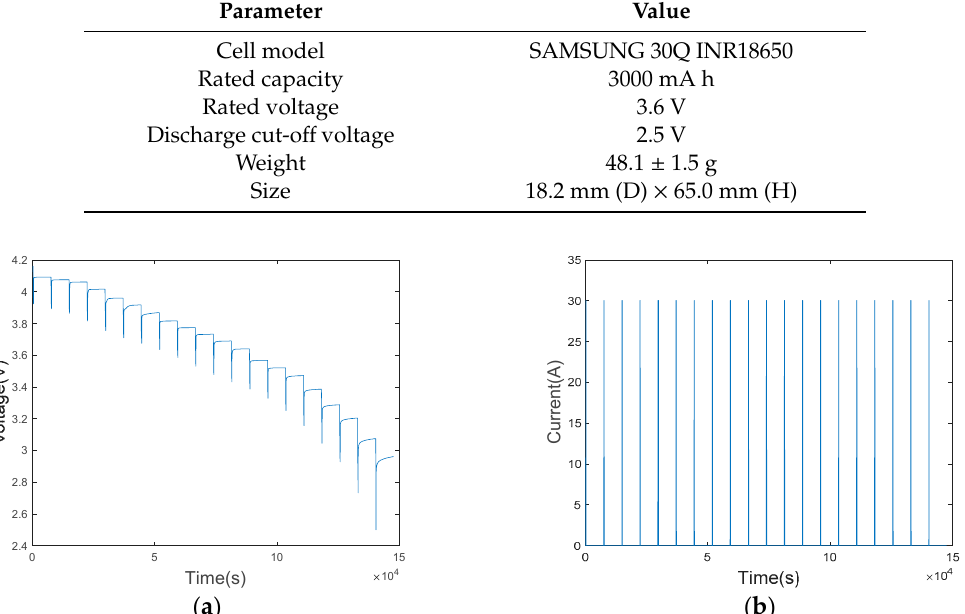
Figure 2. Pulsed discharge current and voltage of the battery. ( a ) Battery pulsed discharge voltage. ( b ) Battery pulsed discharge current.